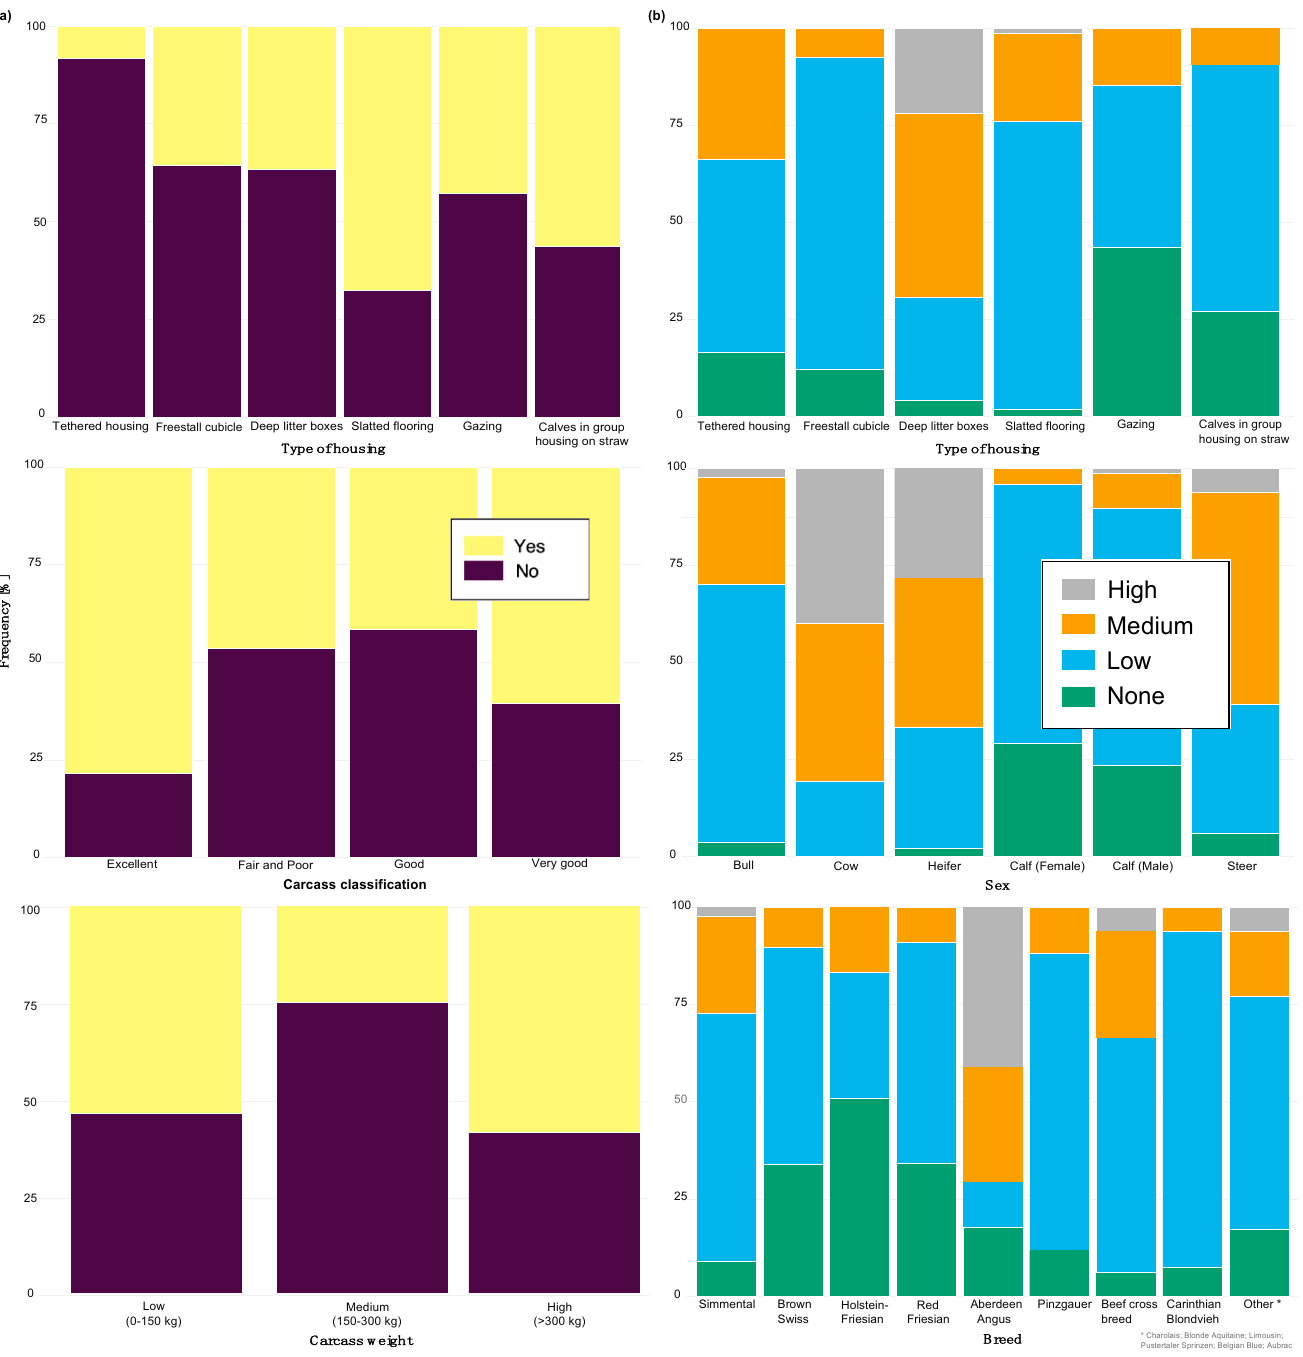
Figure 2. Frequency of recorded ( a ) abomasal mucosa alterations (Yes = presence of abomasal mucosa lesions; No = no presence of abomasal mucosa lesions) stratified by fixed factors considered in the final model, i.e., type of housing, carcass classification, and carcass weight, and ( b ) cleanliness level stratified by fixed factors considered in the final model, i.e., type of housing, sex and breed. After applying the dropping function, the final CLMM included three fixed factors, 226 i.e., “housing type”, “sex”, and “breed”. No correlation between these three factors was 227 identified (i.e., φ c: 0.47 between “housing type” and “sex”; φ c = 0.38 “housing type” vs. 228 “breed”; and φ c = 0.30 “sex” vs. “breed”). All three factors were identified as significant 229 influencing factors on the cleanliness level. The relative frequency of these three factors 230 stratified by “cleanliness level” is shown in Figure 2b. Considering the “housing type” of 231 the cattle, “deep litter boxes” (odds: 40.82) and “calves in group housing on straw bed- 232 ding” (odds: 7.04) had significantly higher odds of contamination compared to cattle kept 233